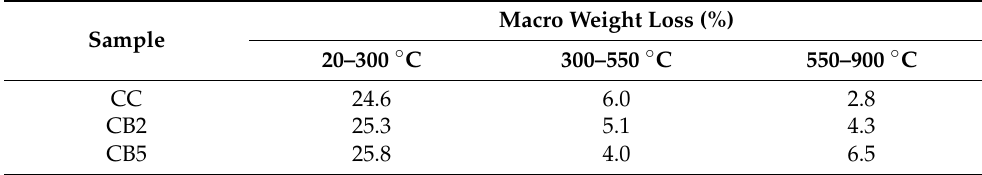
Table 5. Macro weight loss percentages of CC, CB2 and CB5 exposed to different